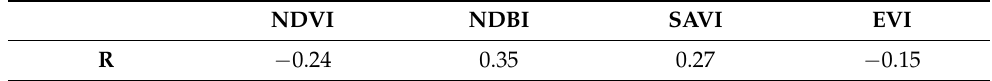
Table 5. The correlation coefficient of AOD with NDVI, NDBI, SAVI, and EVI.